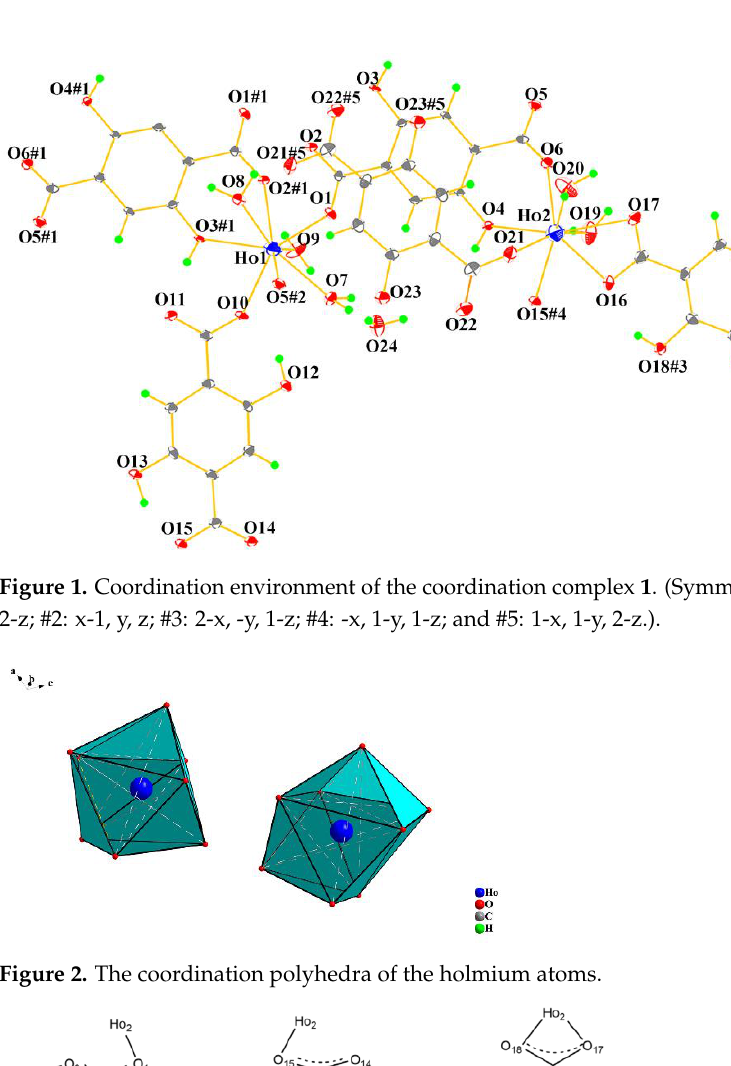
Figure 4. Hydrogen bonds (green dotted line).